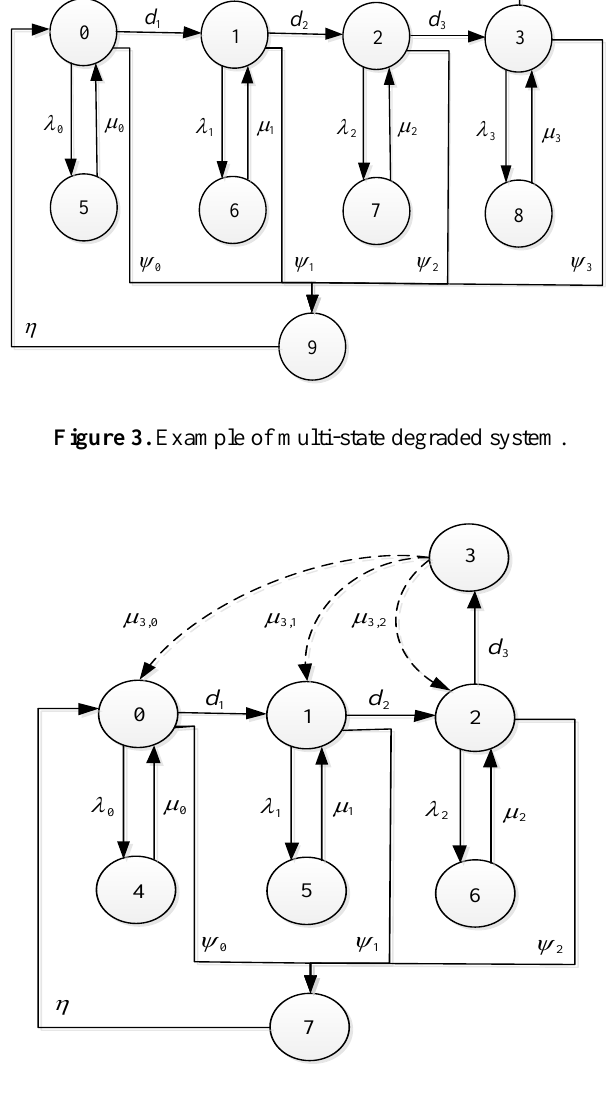
Figure 4. Example of multi-state system subjected to